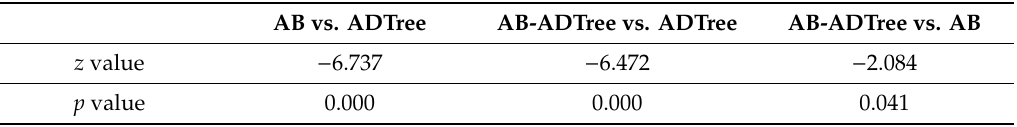
Table 5. Wilcoxon signed ranks test